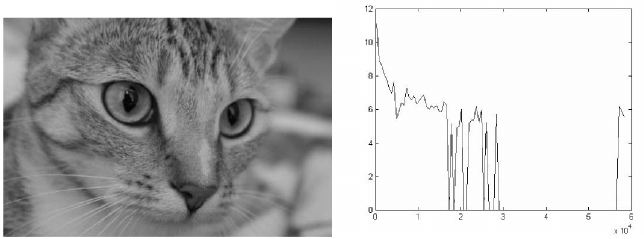
Fig. 3. Full total variation distribution and log histogram total variation distribution of Cat